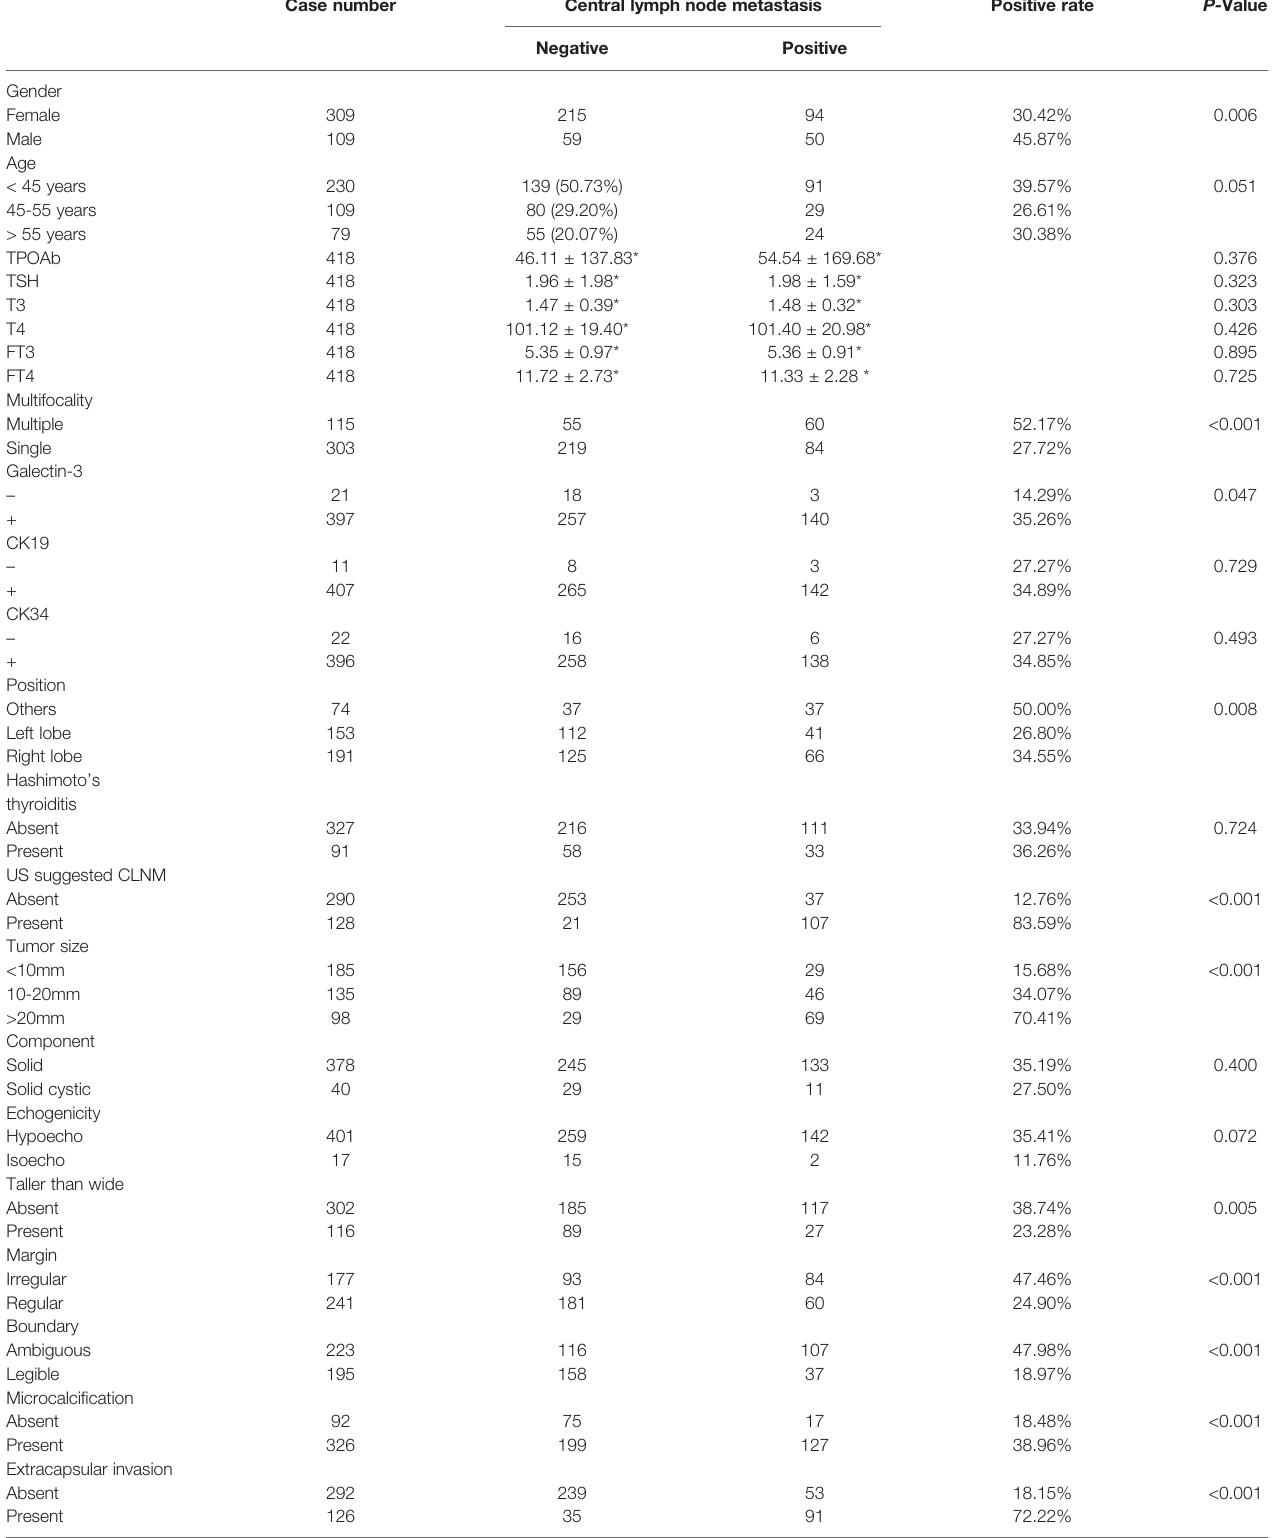
TABLE 1 | Patients